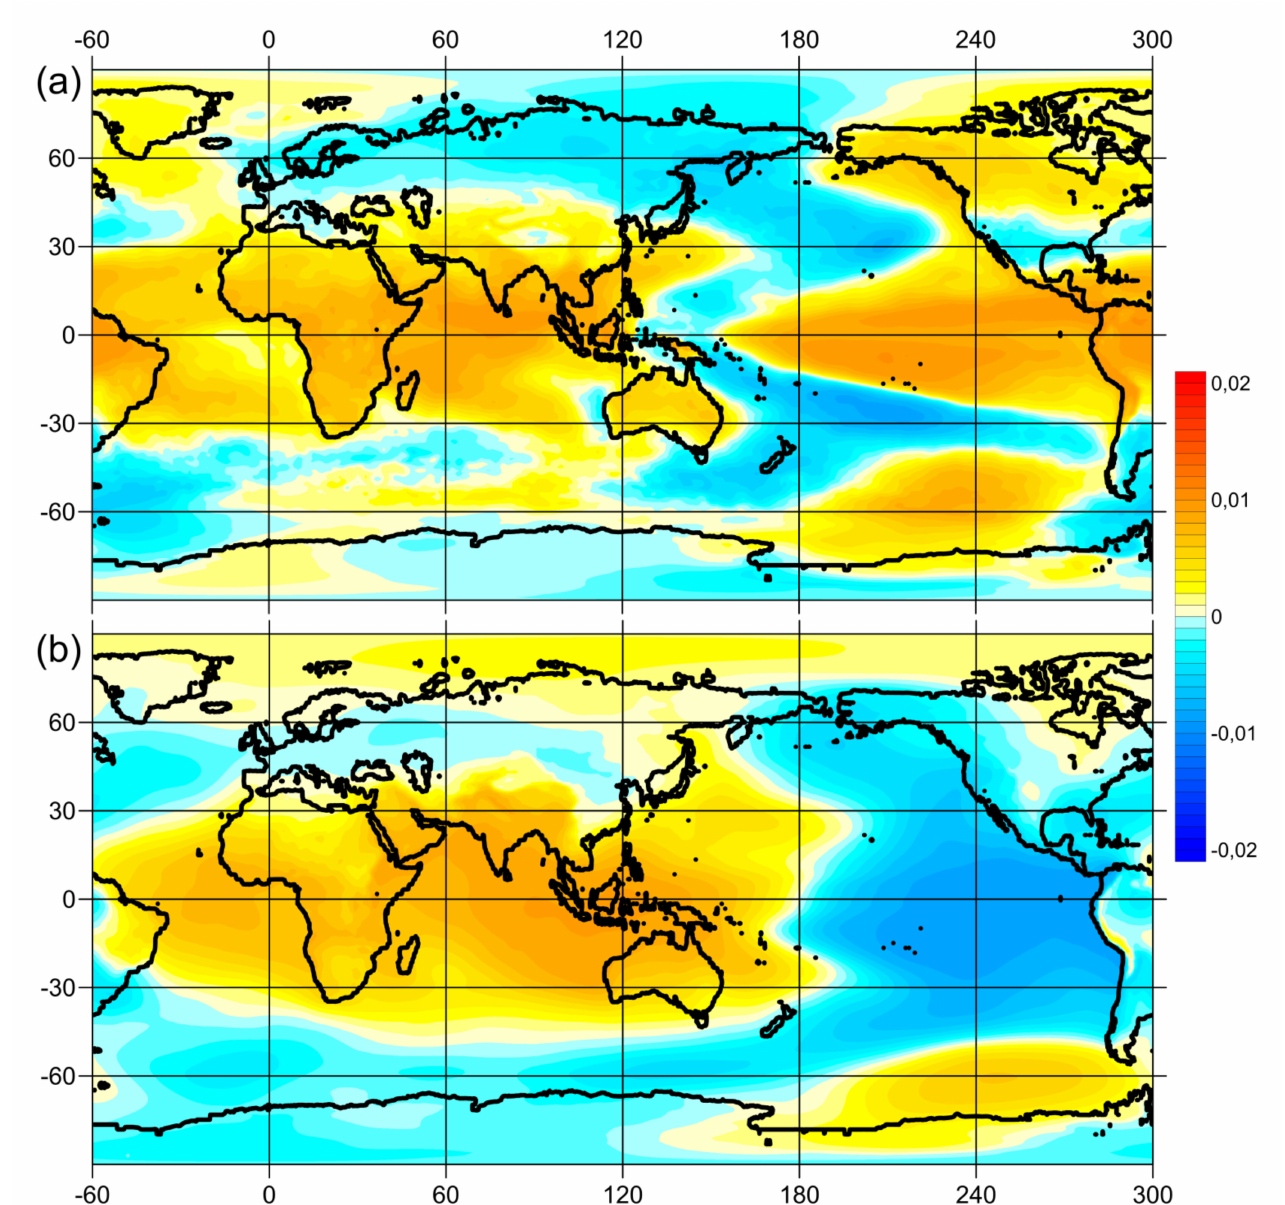
Figure 1. The first empirical orthogonal function (EOF1) of the variability of air temperature anomalies at a height of 2 m from the surface ( a ) and atmospheric pressure at sea level ( b ) with band-pass filtration for 2–7